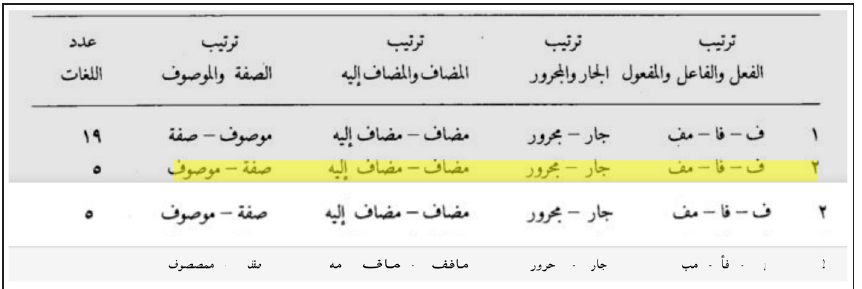
Figure 24: Example of particularly poor transcription on another atypical (table) presentation